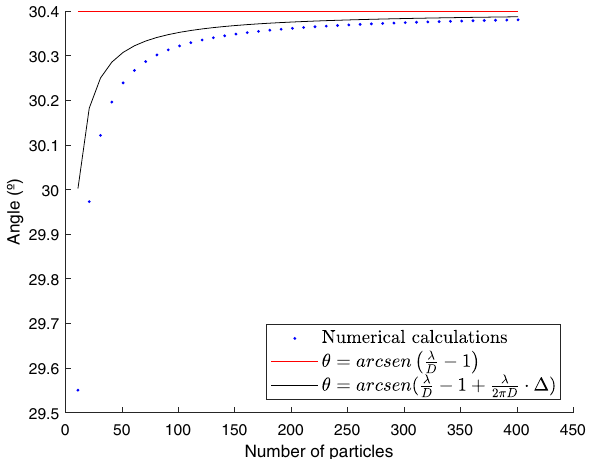
Figure 5. Equilibrium angle versus number of particles in the array for a wavelength of 750 nm. Values obtained with the numerical calculations are plotted in blue. Black line is the value obtained from the analytical prediction (Eq. 24) and the red line marks the resonant value. Note how all three values converge for a large number of particles.